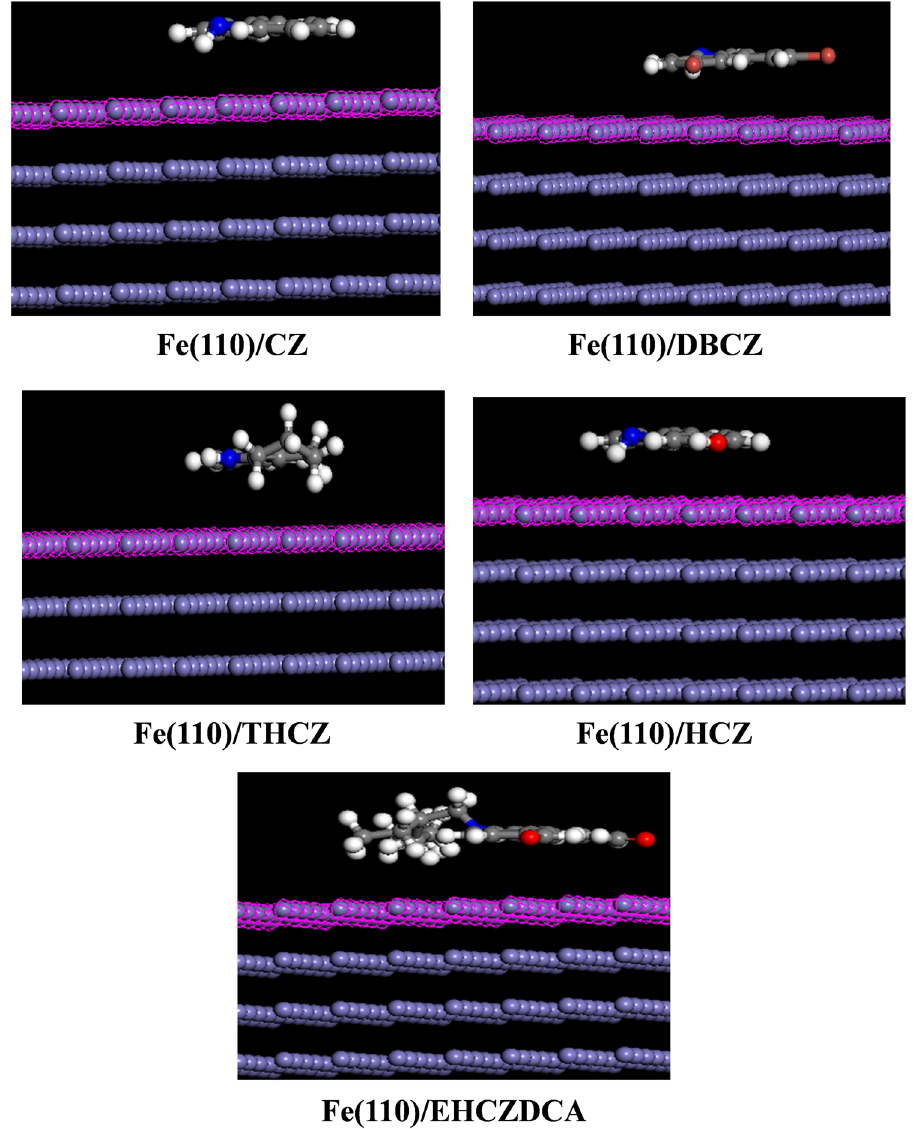
Figure 10. Equilibrium configurations of Fe(110)/inhibitor systems for the studied molecules.